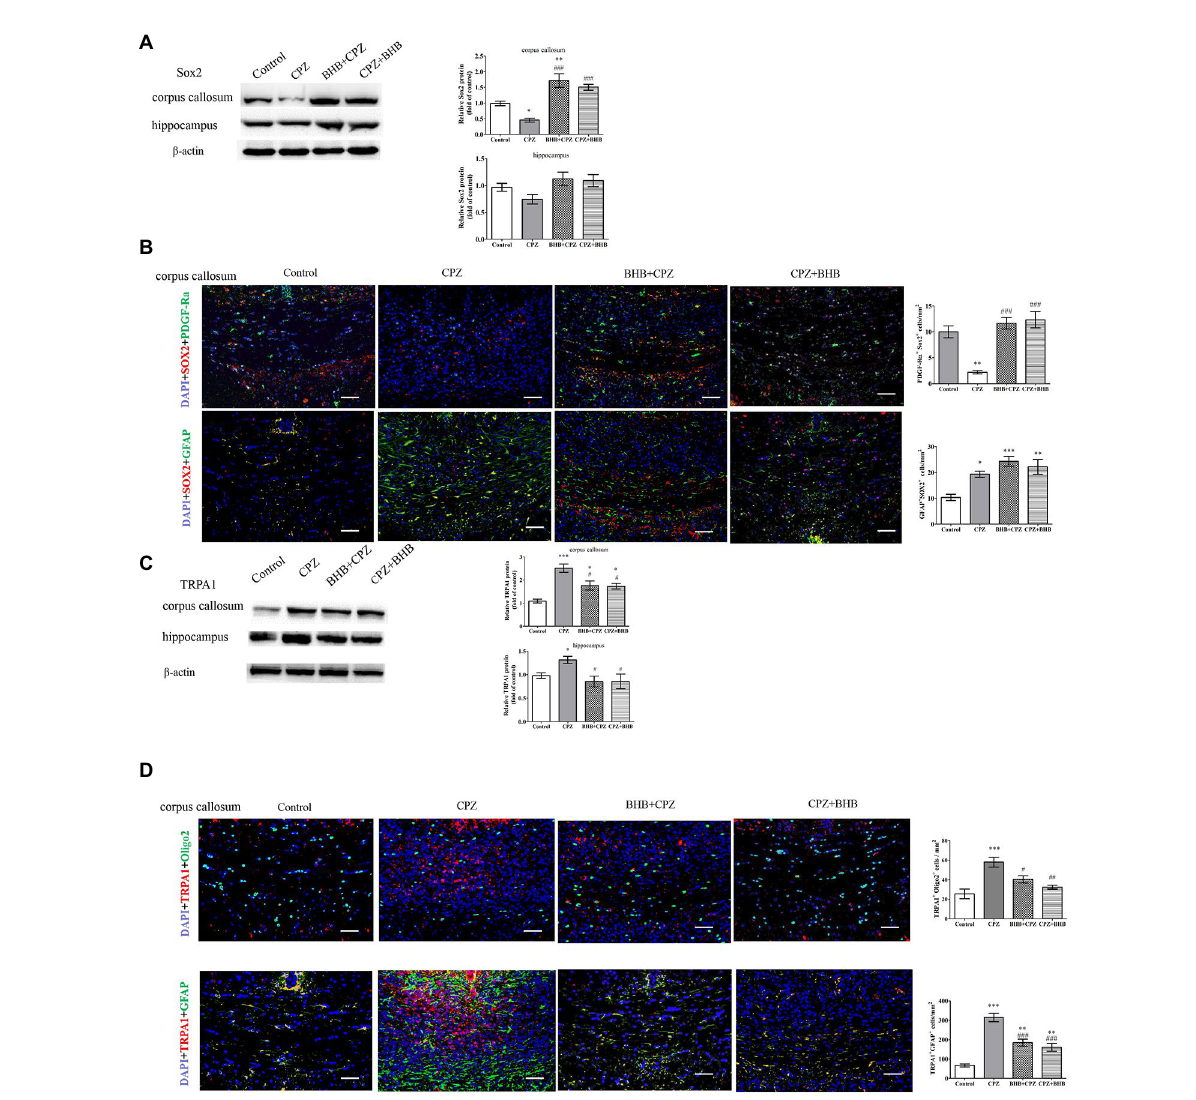
FIGURE 8 Expression of Sox2 and TRPA1 in the corpus callosum shown by immunofluorescence and WB. WB assays indicate the expression of Sox2 (A) , TRPA1 (C) and β -actin (loading control) in the corpus callosum and hippocampus of mice in different groups. Double immunofluorescence staining for PDGF-Ra + Sox2 + and GFAP + Sox2 + (B) , and oligo2 + TRPA1 + and GFAP + TRPA1 + (D) in the corpus callosum of mice. Data are presented as mean ± SEM. N = 3 per experimental group; experiment repeated two times. Scale bars = 50 μ m. * p < 0.05, ** p < 0.01, and *** p < 0.001 versus the control group; # p < 0.05, ## p < 0.01, and ### p < 0.001 versus the CPZ group.